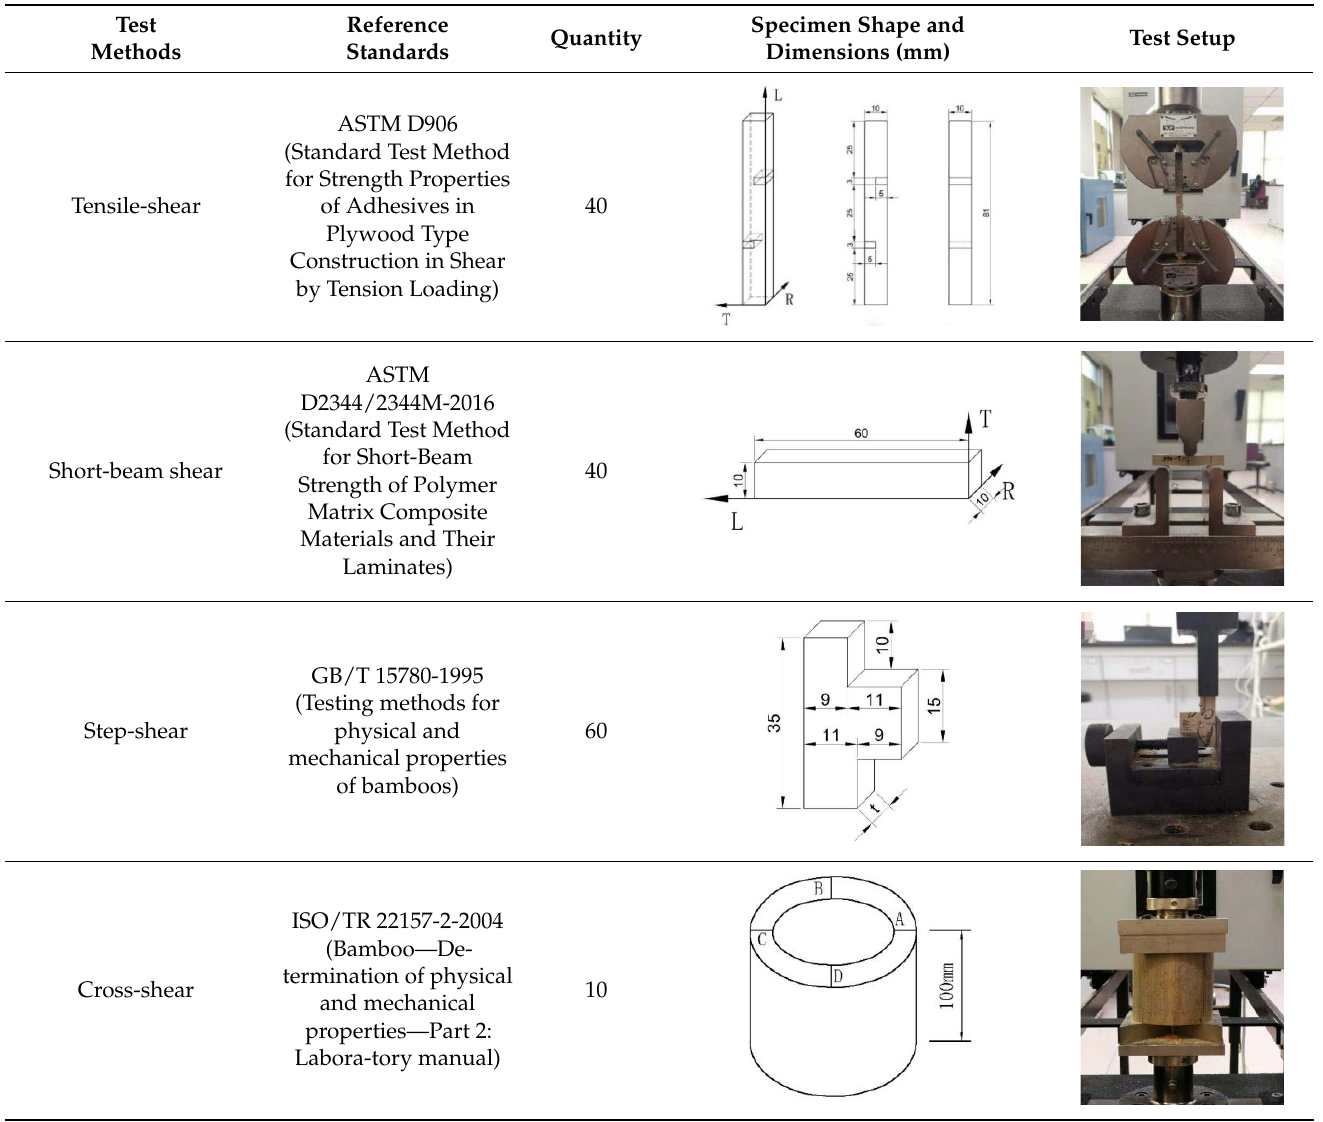
Table 1. The shear-strength-test methods used in the present research.